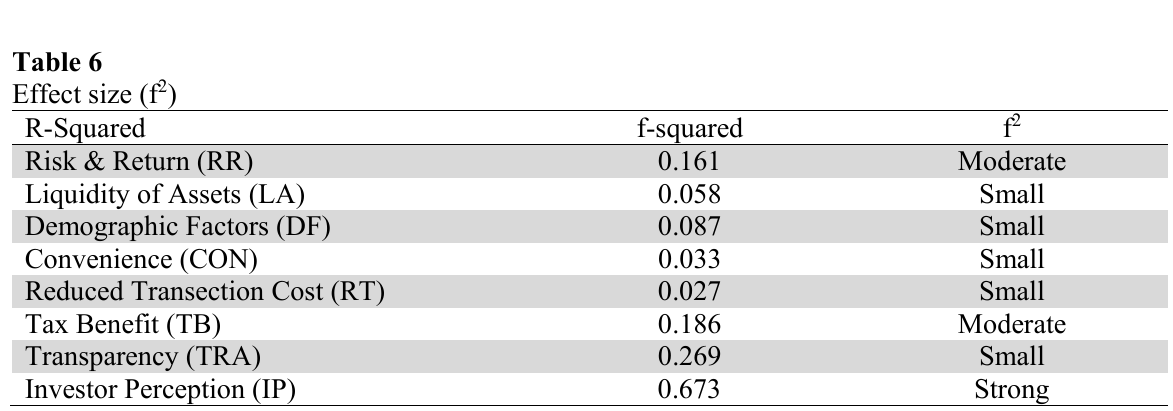
Effect size (f 2 )